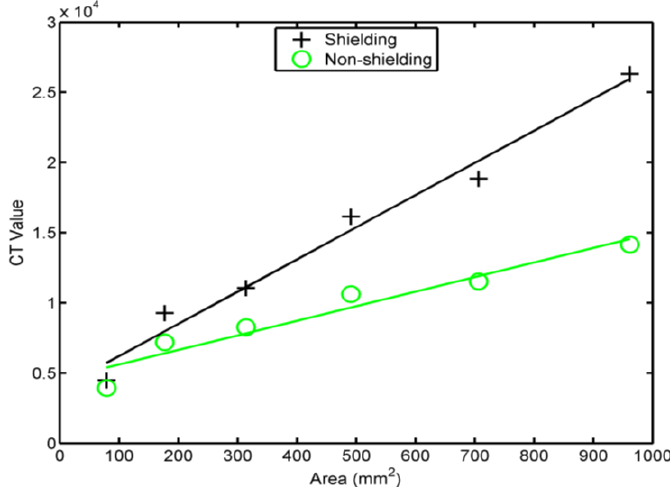
Figure 4. The variations of the projected capacitive-sensing substrates with and without ground